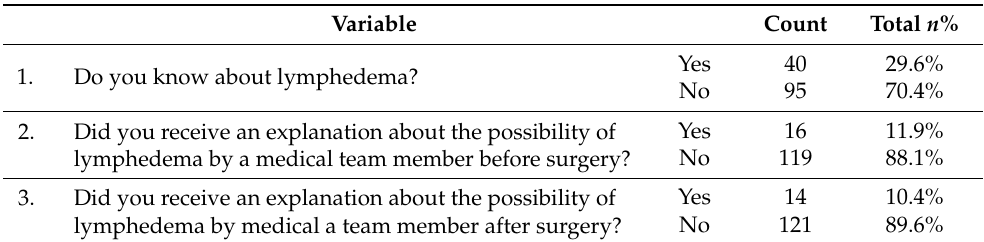
Table 2. Frequency and percentage distribution of the study sample by status of education about breast-cancer-related lymphedema (BCRL) ( n = 135). Variable Count Total n